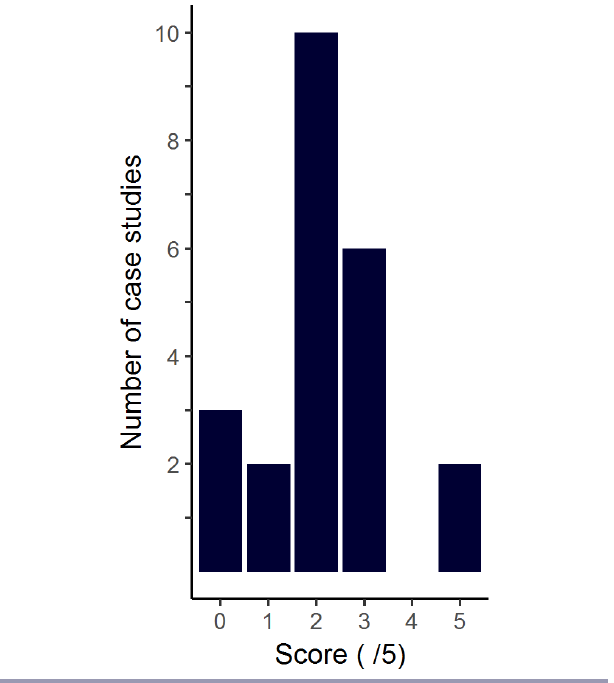
Fig. 3 . Number of published studies per elicitation design score (0–5). One point was attributed for each of the following when clearly mentioned: (1) systematic selection of participants, (2) number of participants, (3) methods used to pool various information sources, and acknowledgement of (4) uncertainty and (5)